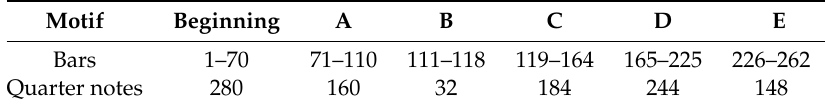
Table 2. Calculation of quarter notes in all